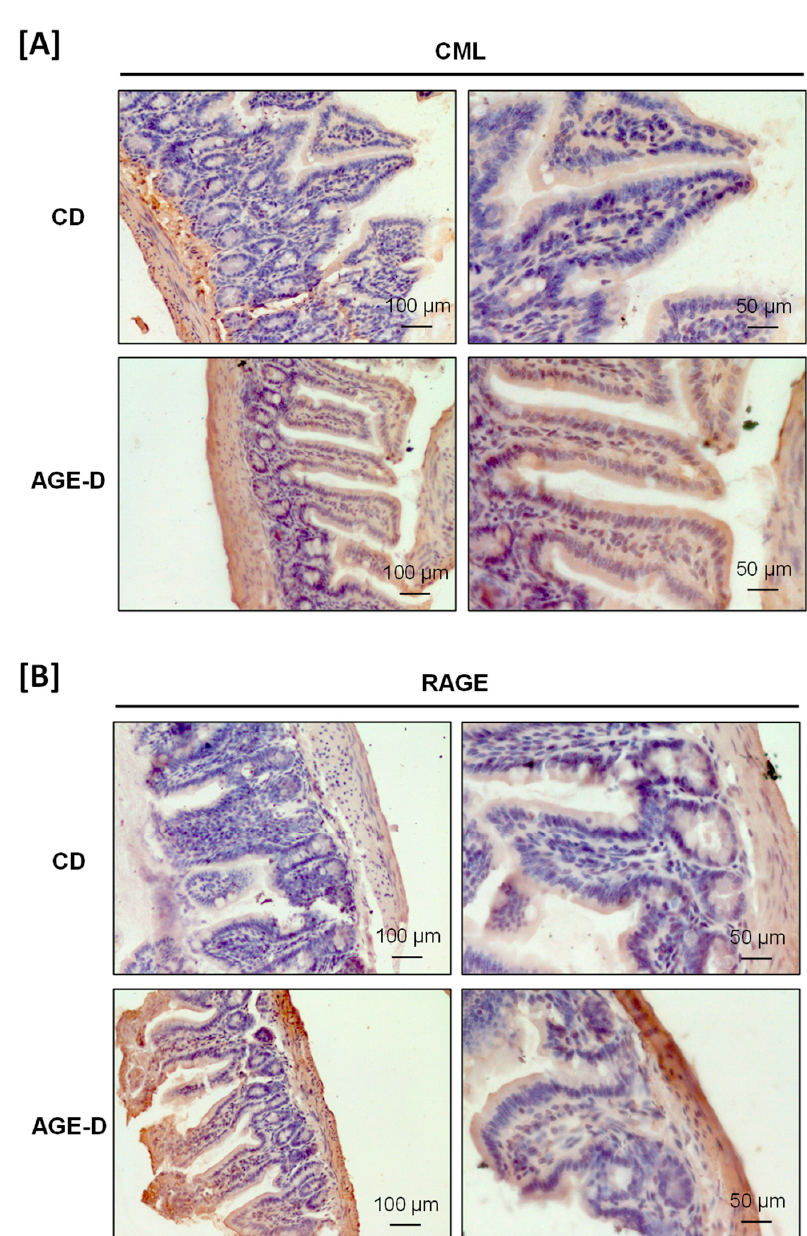
Figure 3. Immunohistochemistry performed on paraffin-embedded ileum portion of intestine. ( A ) Figure3. Immunohistochemistryperformedonparaffin-embeddedileumportionofintestine. ( A )Photomicrographs Photomicrographs at 20× and 40× magnification for CML immunopositivity, showing increased at 20 × and 40 × magnification for CML immunopositivity, showing increased amounts in villi epithelium amounts in villi epithelium of the AGE-D mice. ( B ) Photomicrographs at 20× and 40× magnification of the AGE-D mice. ( B ) Photomicrographs at 20 × and 40 × magnification for RAGE immunopositivity, for RAGE immunopositivity, mostly increased in the basal membrane and muscularis mucosae. mostly increased in the basal membrane and muscularis